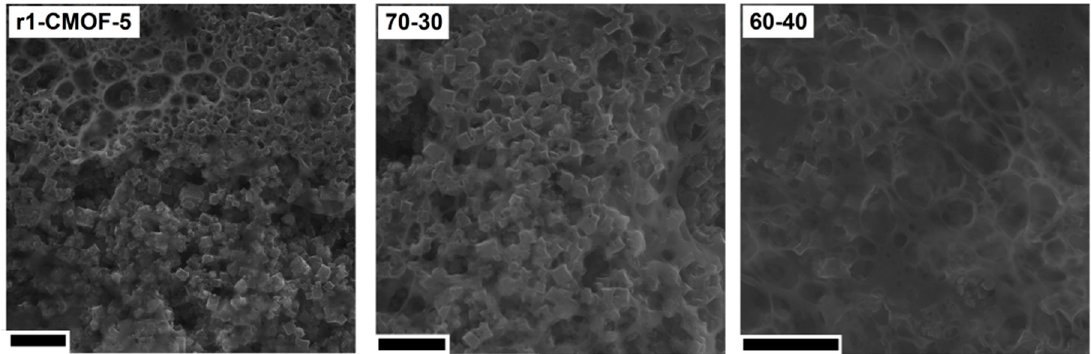
Figure 11. The CV ( A ) and GCD ( B ) curves, correlation of the CV curves at 200 mV/s ( C ) and the GCD capacitance ( D ) of supercapacitors from recycled and pristine carbonized MOF-5 (ratio 60:40).